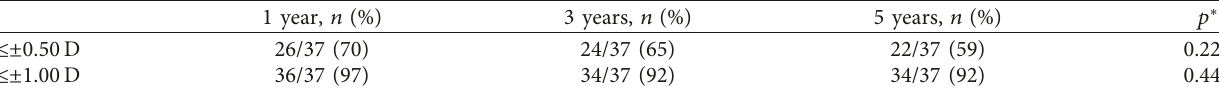
Table 3: Predictability of small-incision lenticule extraction over 5